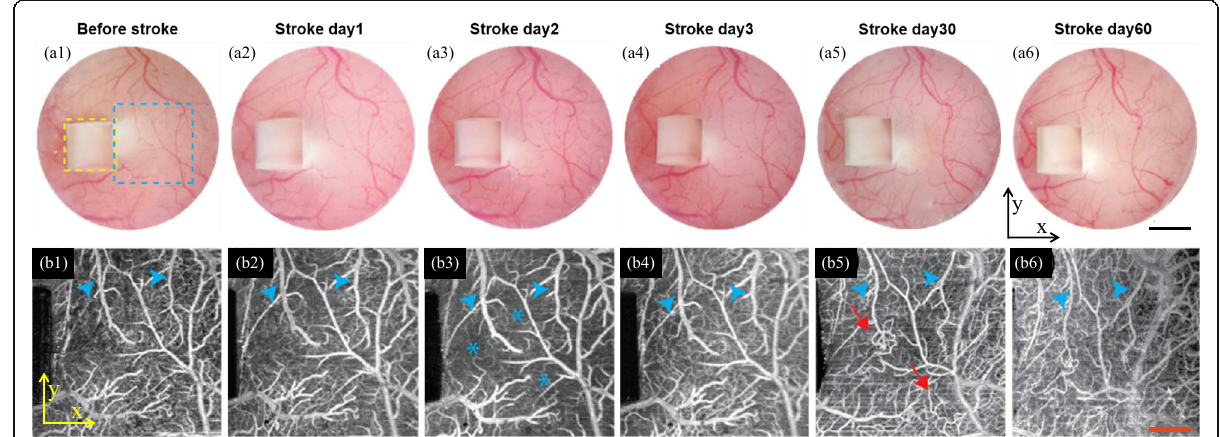
Fig. 1 Longitudinal monitoring of acute (day 1 to 3) and chronic (day 30 and 60) changes after transient middle cerebral artery occlusion (tMCAO) [43]. a1-a6 Six optical microscopic images of the cranial window before and after tMCAO. The yellow dashed square represents a microprism. b1-b6 Six top-view visible optical coherence tomography angiography en face images of the region marked by blue dashed square in a1. Black scale bar: 1mm; red scale bar: 400 μ m